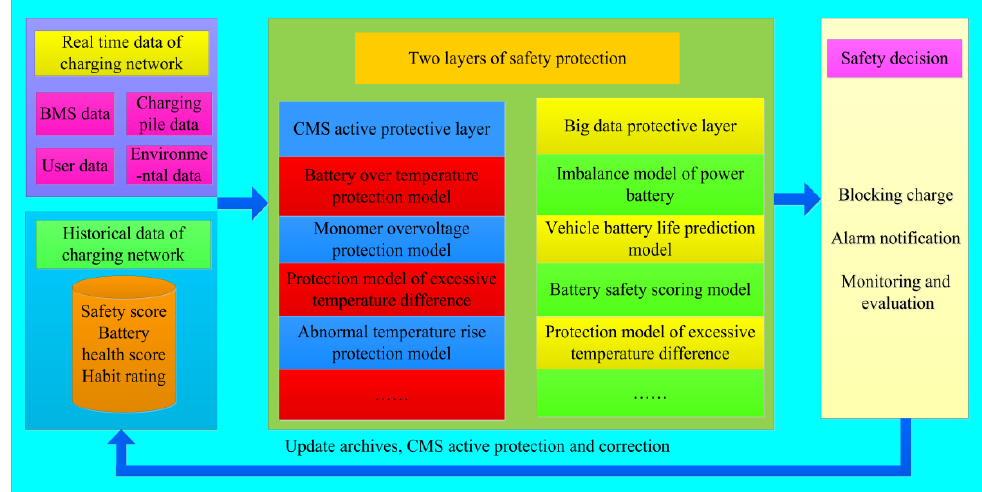
Figure 7. Data protection model.